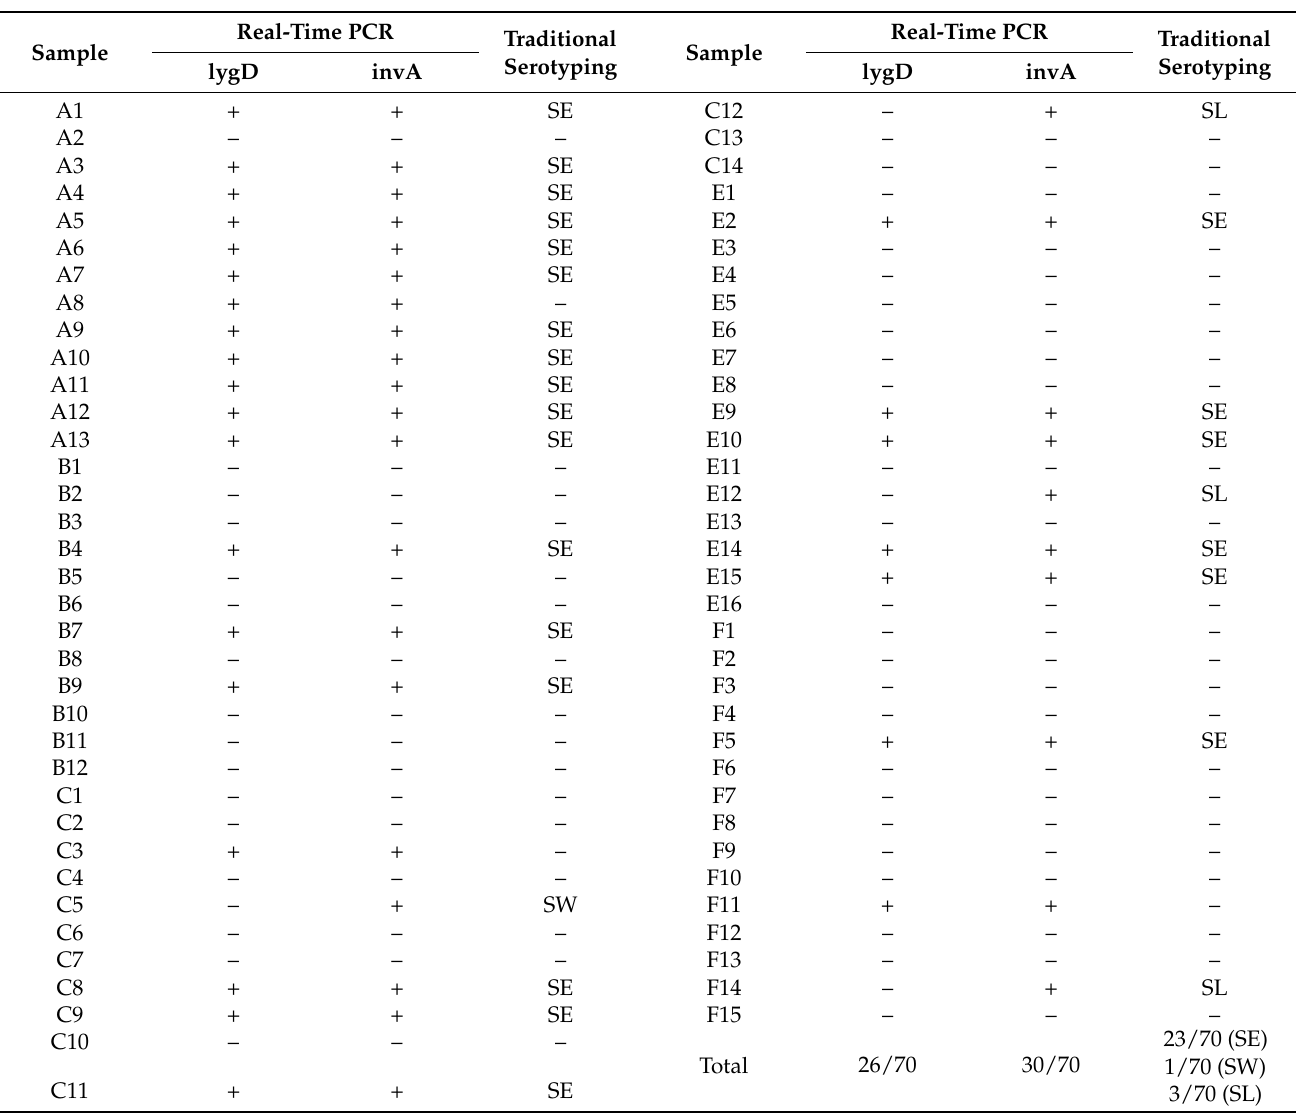
Table 4. Identification of S. enteritidis and Salmonella genus from the contaminated chicken eggs.